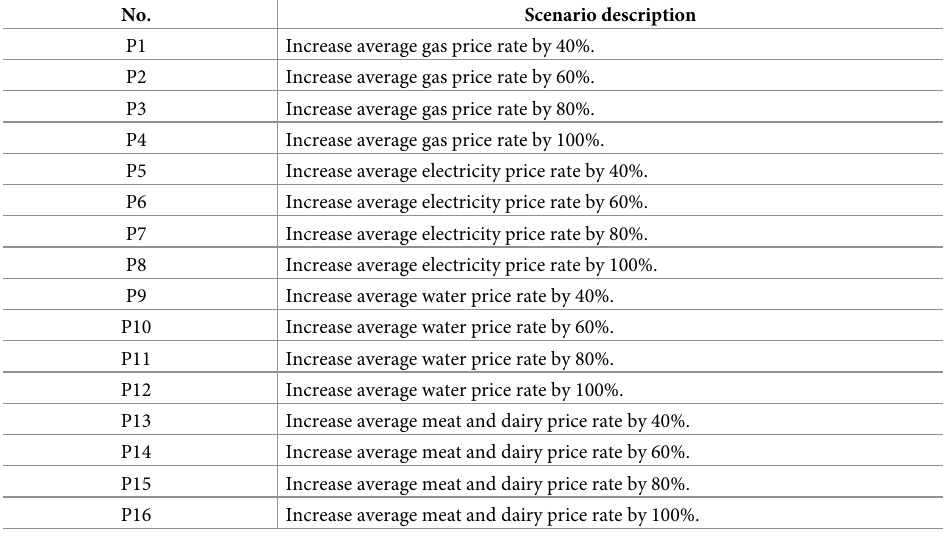
Table 1. Overview of FEW conservation strategies—price strategies (P). No. Scenario description P1 Increase average gas price rate by 40%. P2 Increase average gas price rate by 60%. P3 Increase average gas price rate by 80%. P4 Increase average gas price rate by 100%. P5 Increase average electricity price rate by 40%. P6 Increase average electricity price rate by 60%. P7 Increase average electricity price rate by 80%. P8 Increase average electricity price rate by 100%. P9 Increase average water price rate by 40%. P10 Increase average water price rate by 60%. P11 Increase average water price rate by 80%. P12 Increase average water price rate by 100%. P13 Increase average meat and dairy price rate by 40%. P14 Increase average meat and dairy price rate by 60%. P15 Increase average meat and dairy price rate by 80%. P16 Increase average meat and dairy price rate by